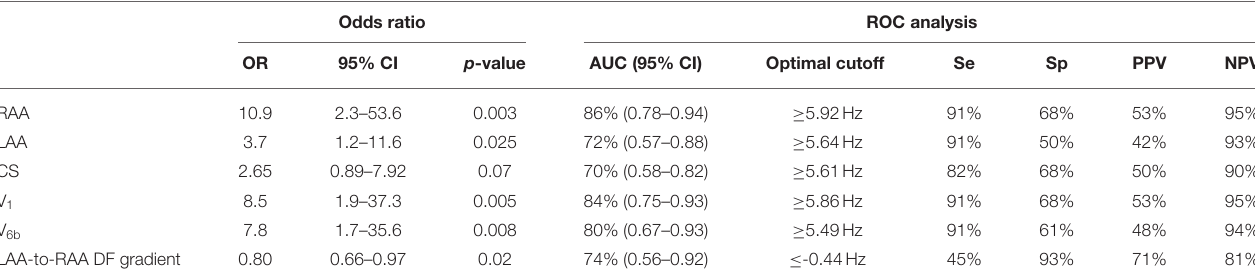
TABLE 3 | Baseline ECG and EGM DFs as predictors of procedural ablation outcomes (NLT patients vs. LT_Rec + LT_SR patients). Odds ratio ROC